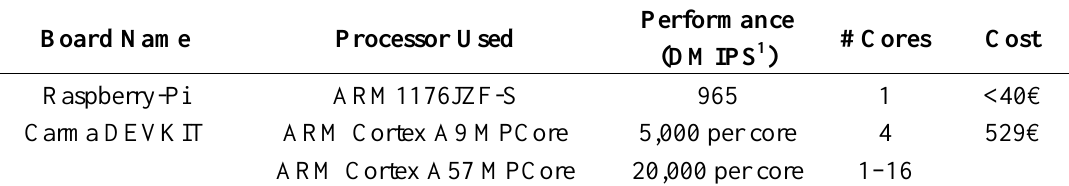
Table 2. Summary of features from systems used.